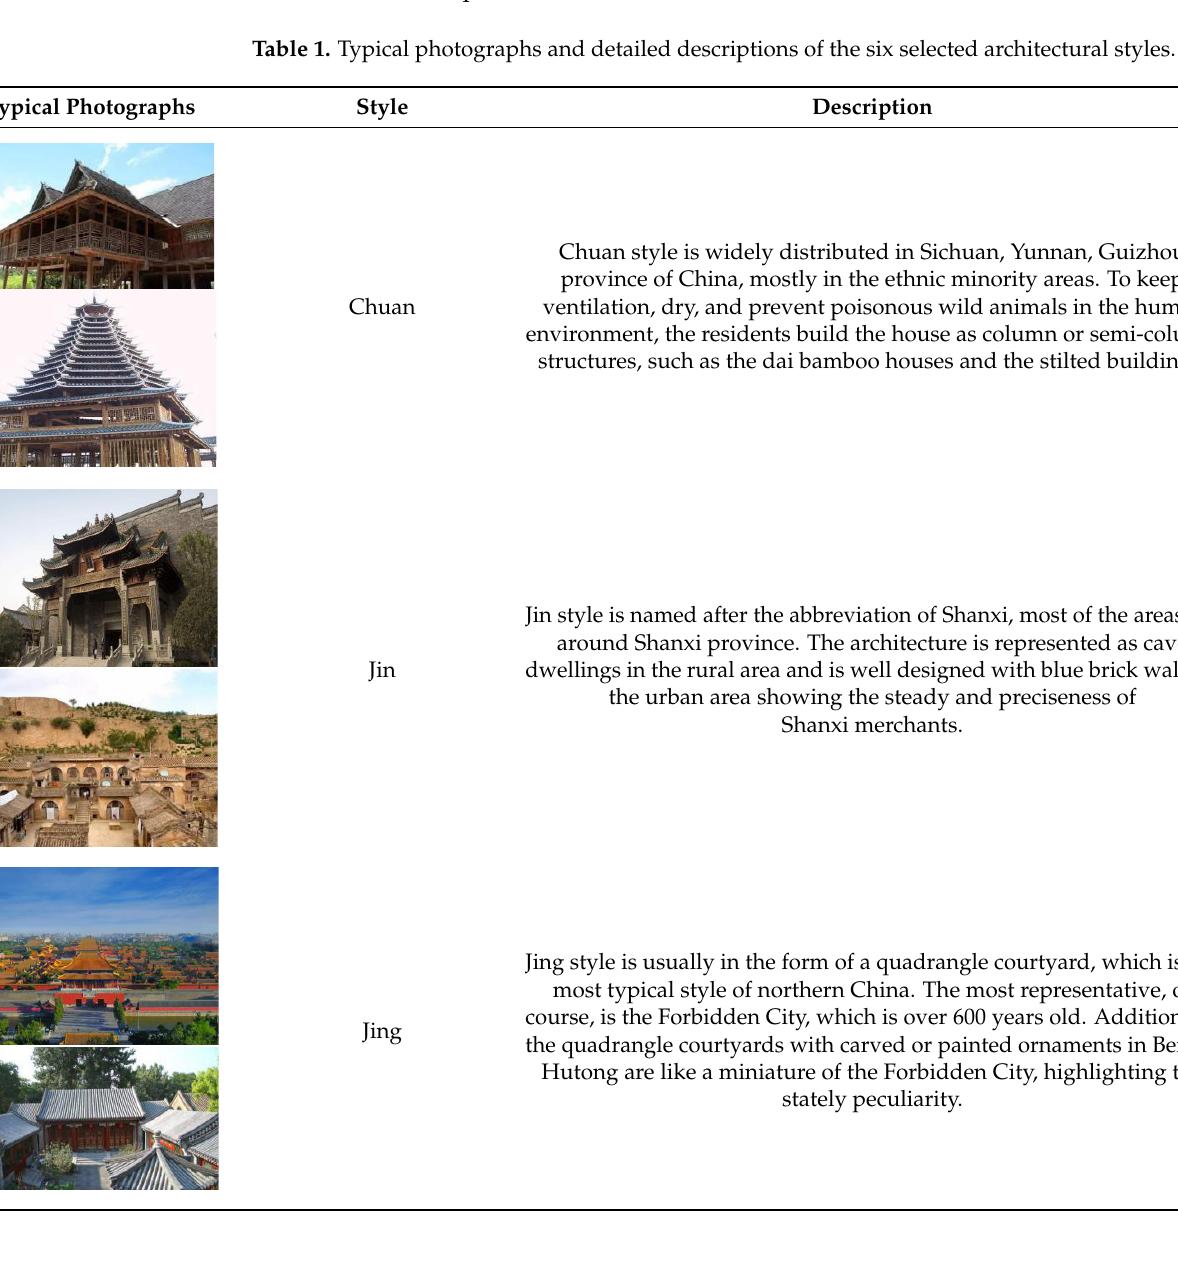
Figure 2. Geographical locations of the CTSs across China.